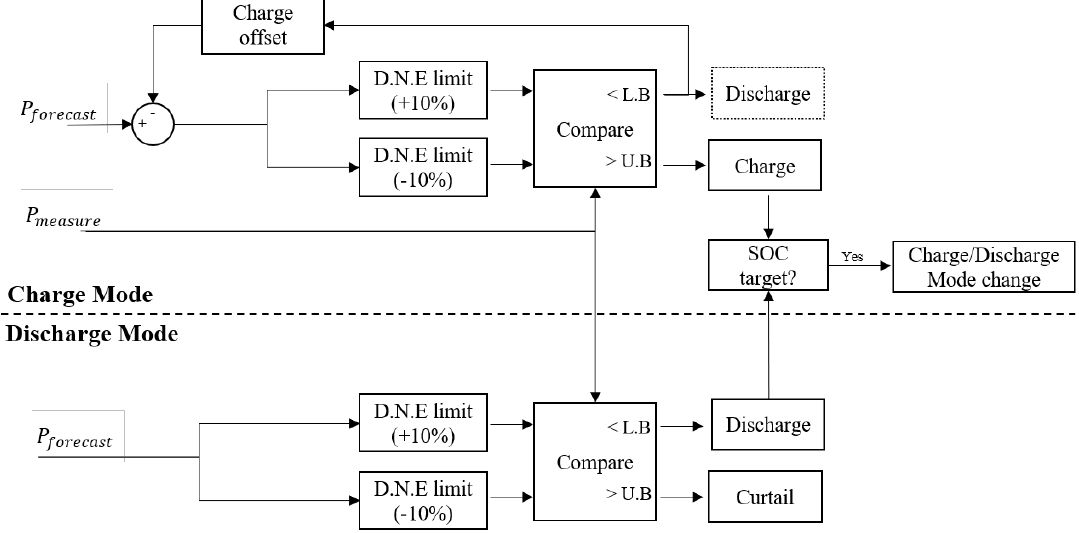
Figure 4. Operation of ESS in a dispatchable